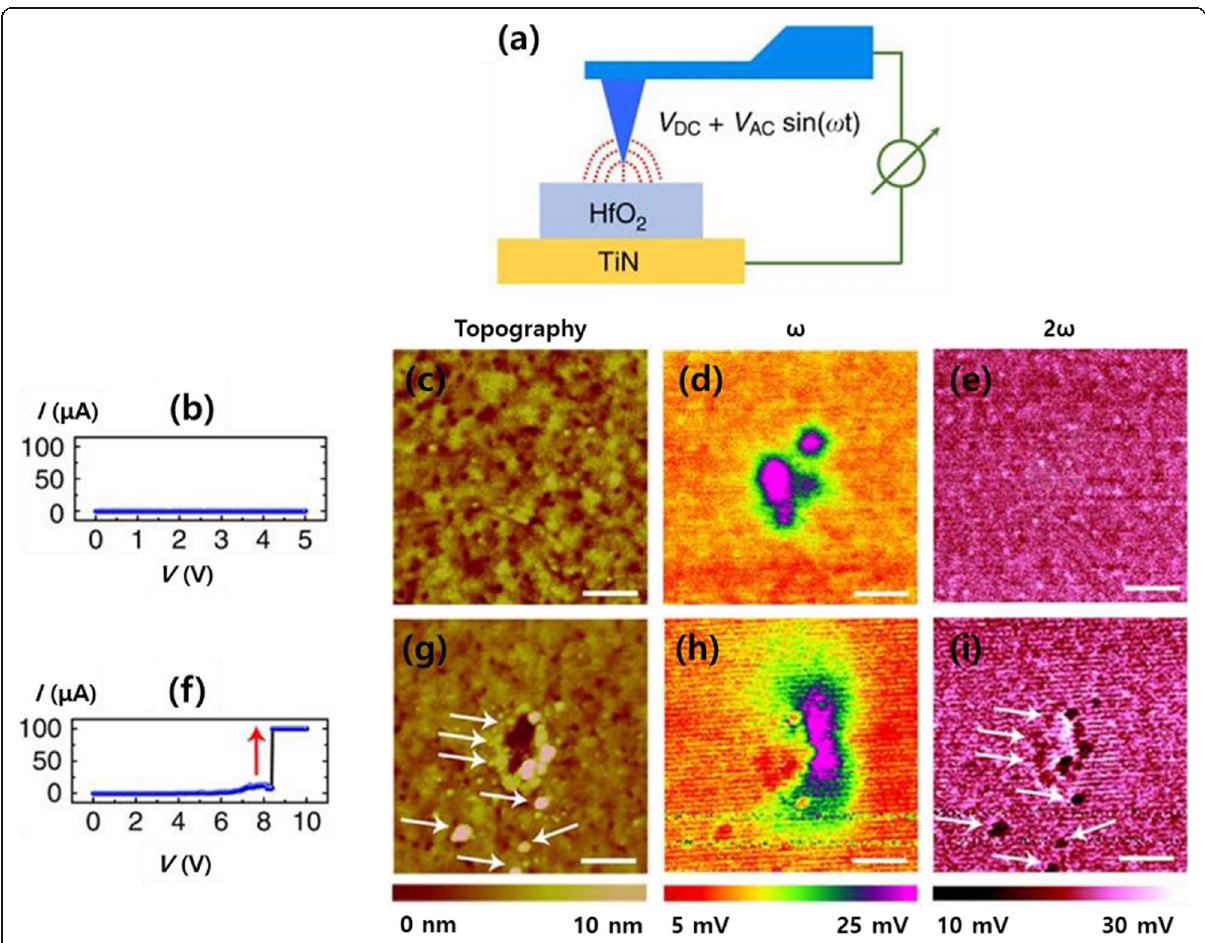
Fig. 4 Probing HfO 2 film during the switching process using EFM. a Schematic of electrostatic force microscopy (EFM) measurements of an HfO 2 / TiN system. b-e Electrical properties ( b ), topography ( c ), ω ( d ), and 2 ω ( e ) results up to 5 V during voltage sweep. f-i Electrical property ( f ), topography ( g ), ω ( h ), and 2 ω ( i ) results up to 10 V during voltage sweep. (Scale bar in the images, 4 μ m). Reprinted from Yang et al. (2017) ( Nat